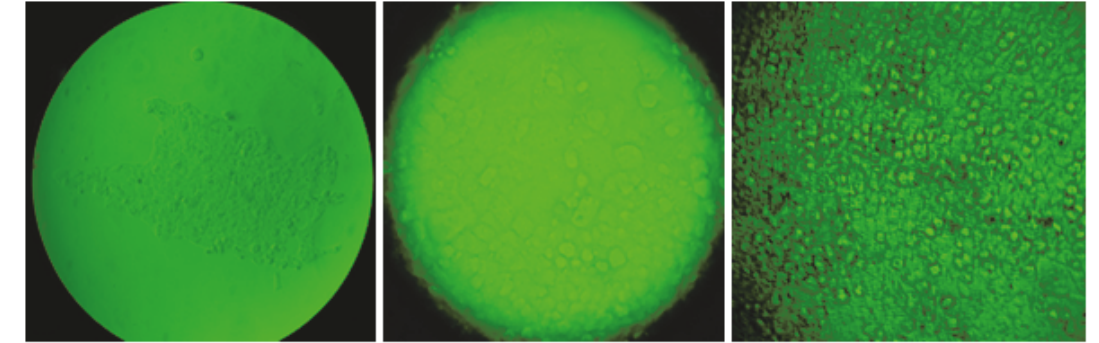
Figure 5: Microscopic images of CaCo-2 adhesion cells.